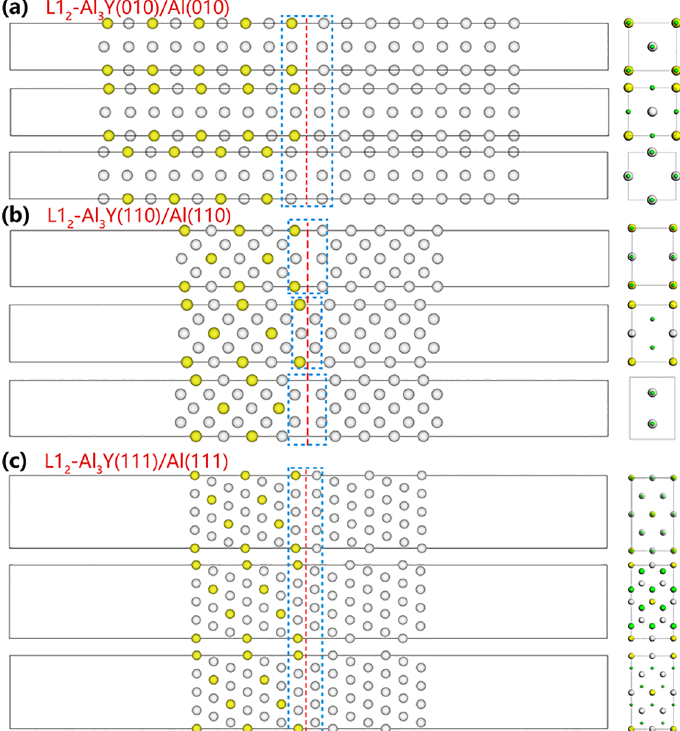
Figure 2. Atomic arrangements at various interfaces. Green spheres show the Al atom of the Al matrix. The red dash line denotes the interface, and the atomic arrangement is in the blue dash rectangle (Green spheres show the Al atom of the Al matrix.).